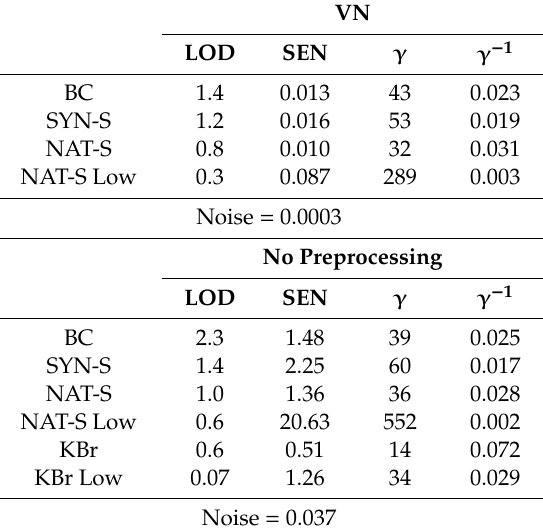
Table 3. Sensitivity, analytical sensitivity, the limit of detection (LOD), and noise of the models, with and without vector normalization (VN) preprocessing.